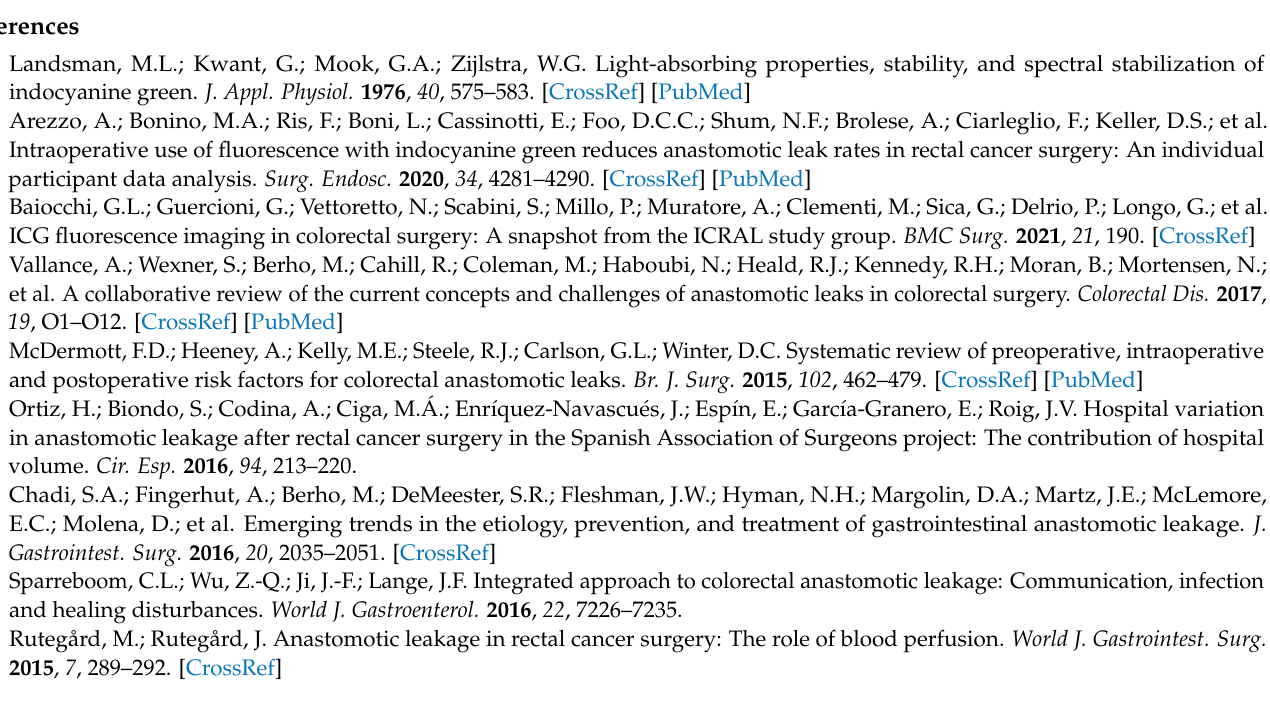
trials; Table S3: PRISMA checklist. Figure S1: A summary table of the review authors’ judgements for each risk of bias item for each randomized study; Figure S2: A plot of the distribution of the review authors’ judgements for each risk of bias item across randomized studies; Figure S3: A summary table of the review authors’ judgements for each risk of bias item for each non-randomized study; Figure S4: A plot of the distribution of the review authors’ judgements for each risk of bias item across non-randomized